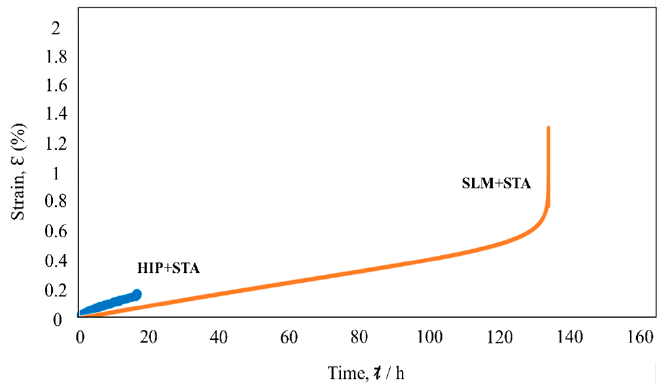
Figure 11. Fracture surfaces of ( a ) HIP + STA specimen and ( b ) SLM + STA specimen tested at room temperature; fracture surfaces of ( c ) HIP + STA specimen and ( d ) SLM + STA specimen tested at